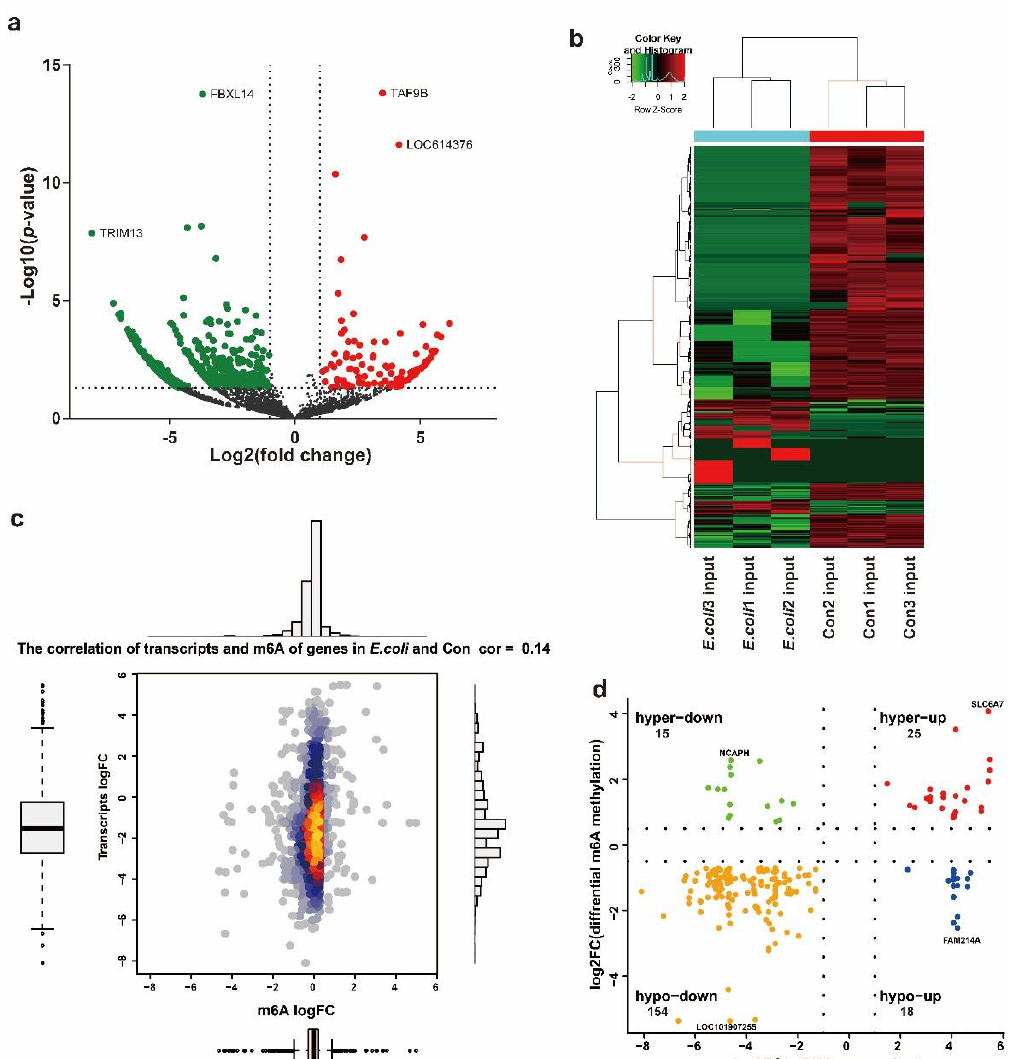
Figure 5. Conjoint analysis of m 6 A methylation and mRNA expression. ( a ) Volcano plots showing the differentially expressed mRNAs between the E. coli and Con groups with statistical significance (fold change ≥ 2.0 and p < 0.05). ( b ) Heat map demonstrating the differentially expressed mRNAs in three E. coli input samples and three control input samples. ( c ) Correlation of expression and m 6 A modification of transcripts in the E. coli group compared with the Con group. ( d ) Four-quadrant graph displaying the distribution of differential transcripts with m 6 A methylation and expression in the E. coli group.